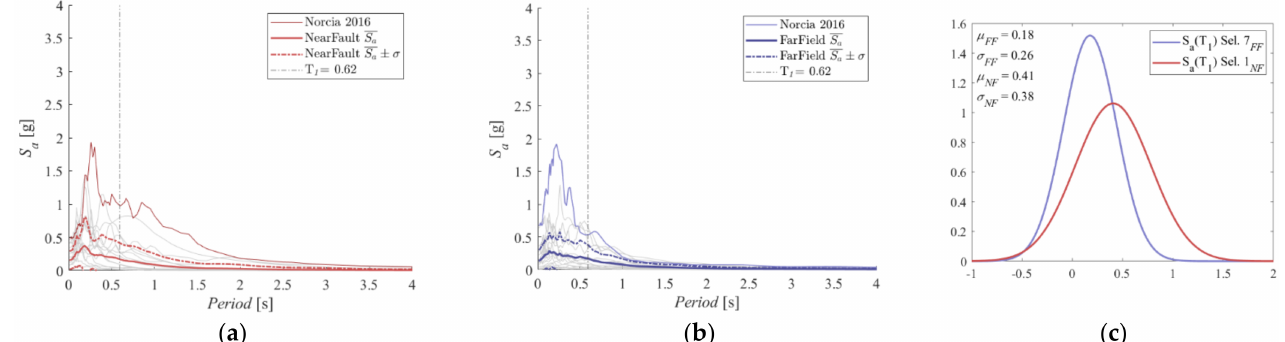
Figure 1. Elastic response spectra of the ( a ) near-fault and ( b ) far-field subset of records. The figures highlight the two records of the 2016 Norcia Earthquake, S a is the average response spectra from the two set, and S a ± σ is the range of variance according to standard deviation. ( c ) Normal distribution of S a for T = T 1 .